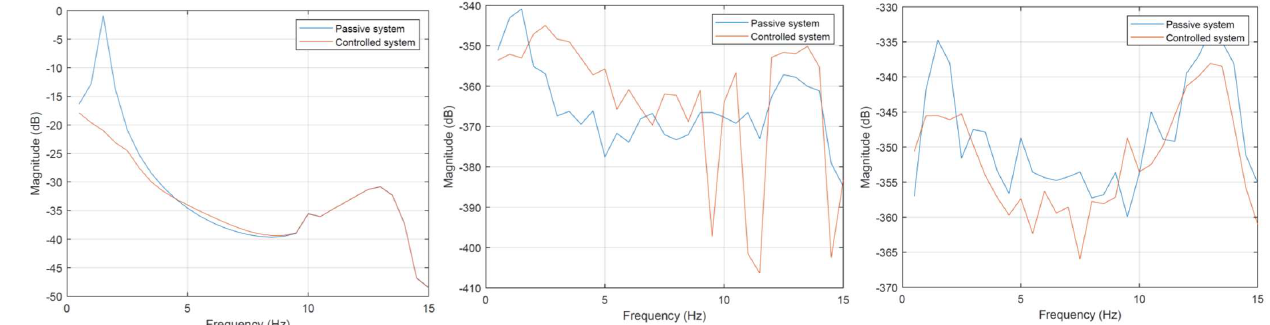
15 of 22 Figure 12. Vibration transmissibility characteristics for asymmetrical excitation of the front axis— right wheel delayed by π/2, relative to the left. Displacement of the center of mass—left character- istic, pitch angle—central characteristic, roll angle—right characteristic.